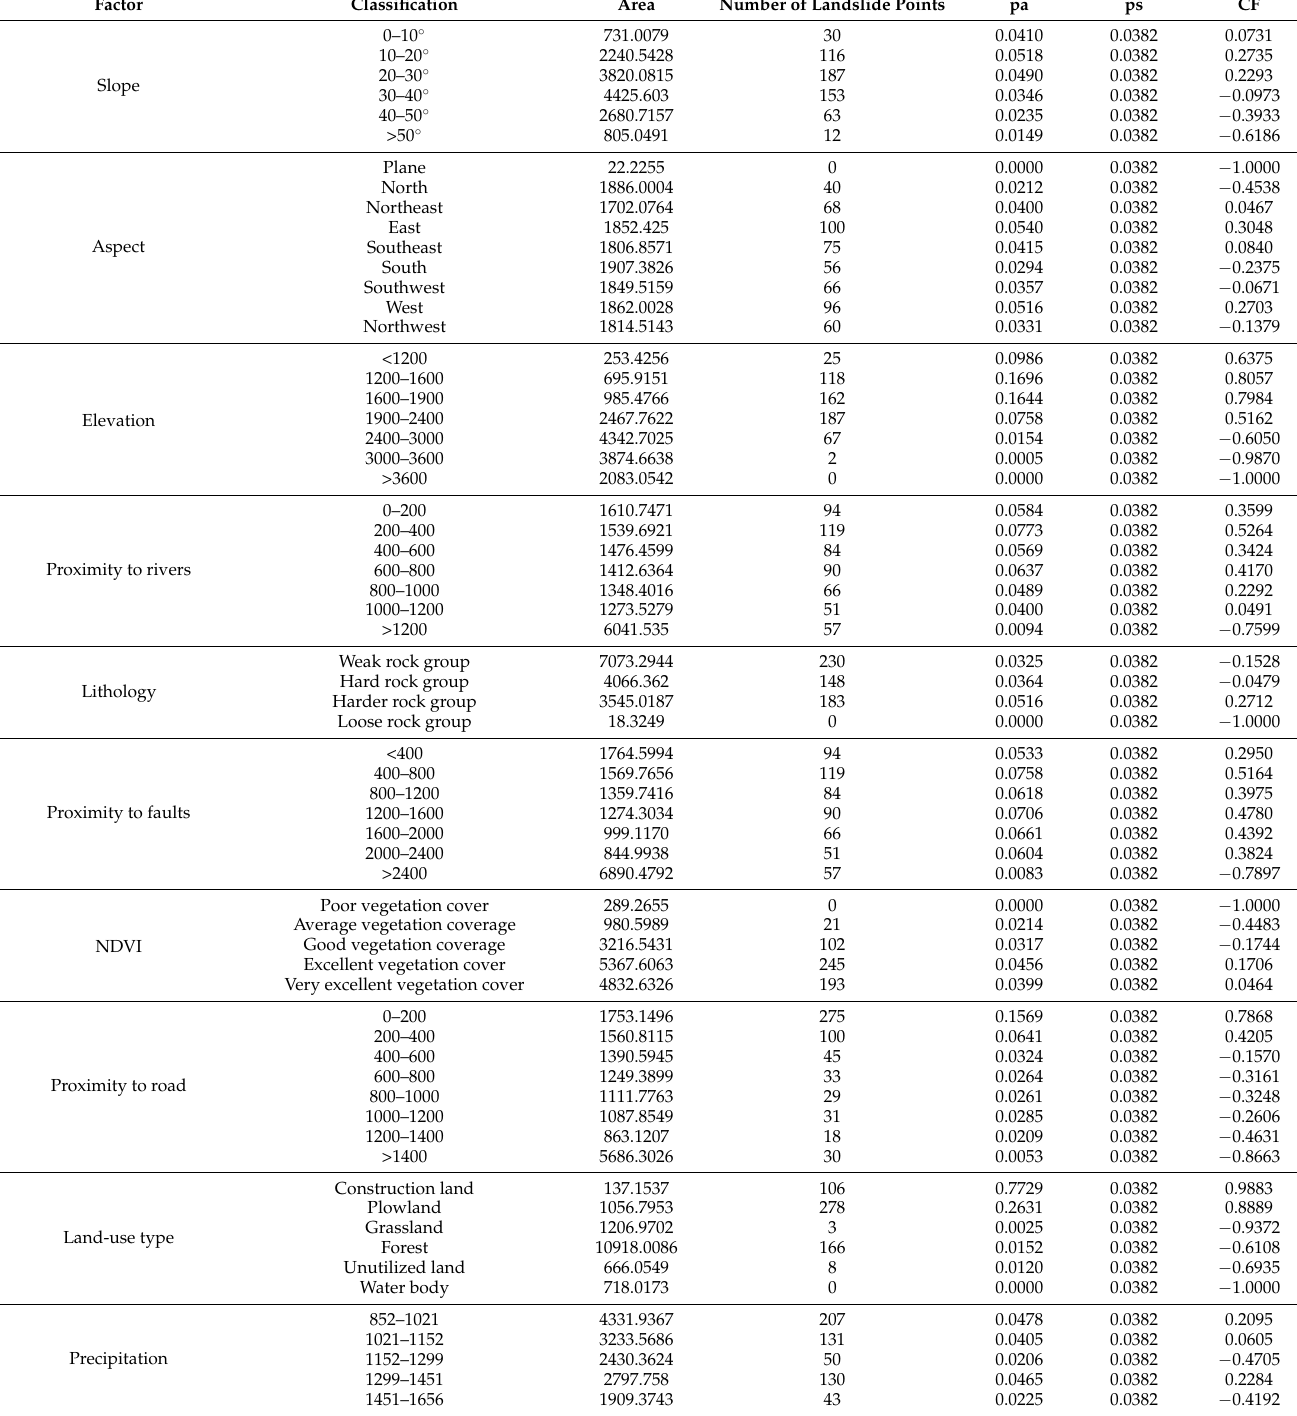
Table 3. CF values of each